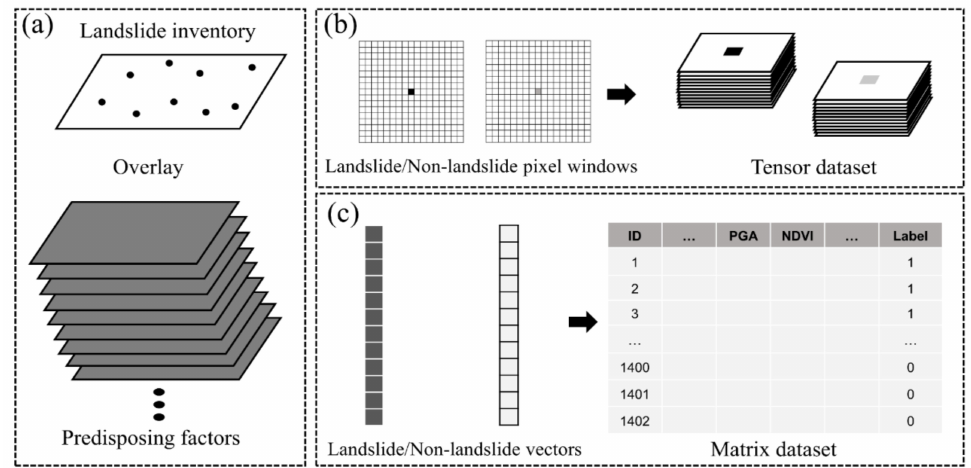
Figure 4. Schematic diagram of the spatial datasets generation process: ( a ) Stacking the original datasets, ( b ) preparing the tensor dataset for CNN-based model, and ( c ) the matrix dataset for conventional machine learning